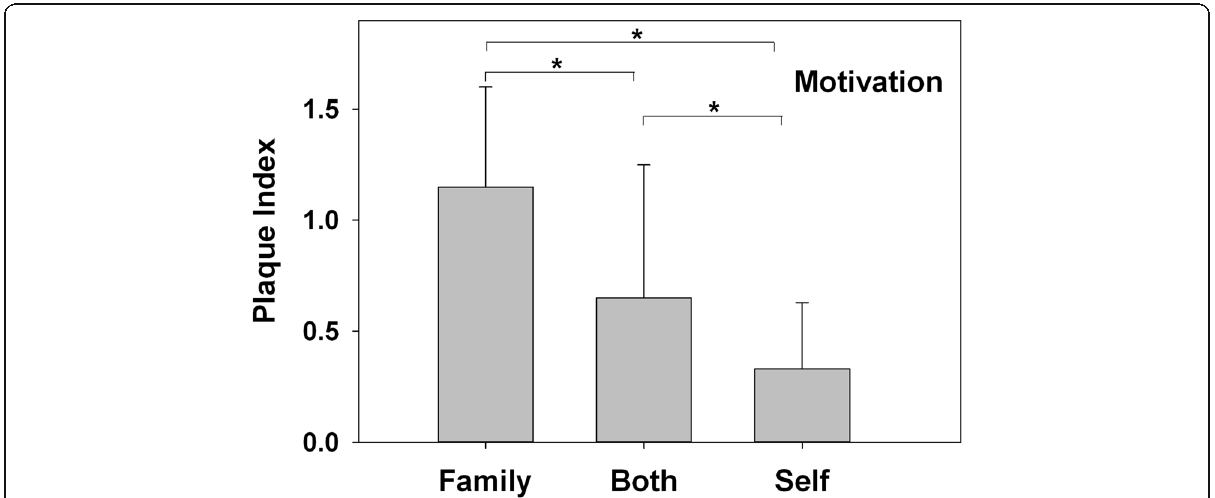
Fig. 4 Biofilm formation in patients with different motivations to undergo orthodontic treatment. “ Family-motivated ” patients had more biofilm formation, followed by subjects who were “ self- and family-motivated, ” and “ self-motivated ” ( P <